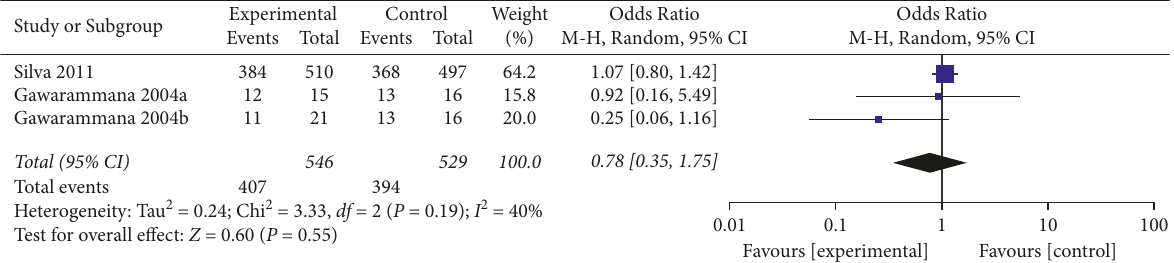
Figure 7: Forest plot of ADRs associated with antivenom use following snakebite between the prehydrocortisone with or without other drugs groups and the placebo or no premedication groups in three comparisons from two RCTs.